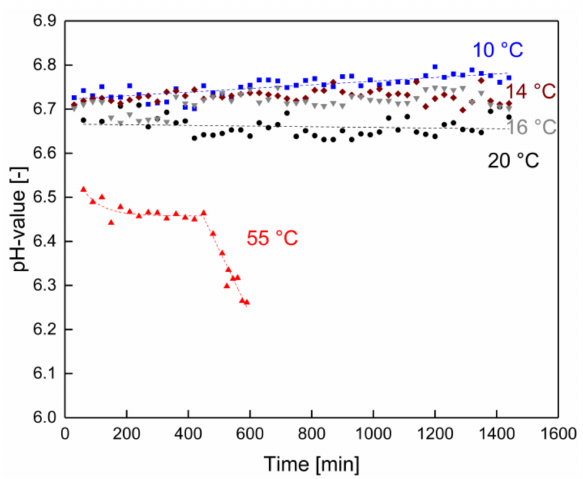
Figure 3. pH value as a function of the filtration time at processing temperatures of 10 ( (cid:4) ), 14 ( (cid:95) ), 16 ( (cid:72) ), 20 ( • ), and 55 ◦ C ( (cid:78) ). Dotted lines are guides for the eye.